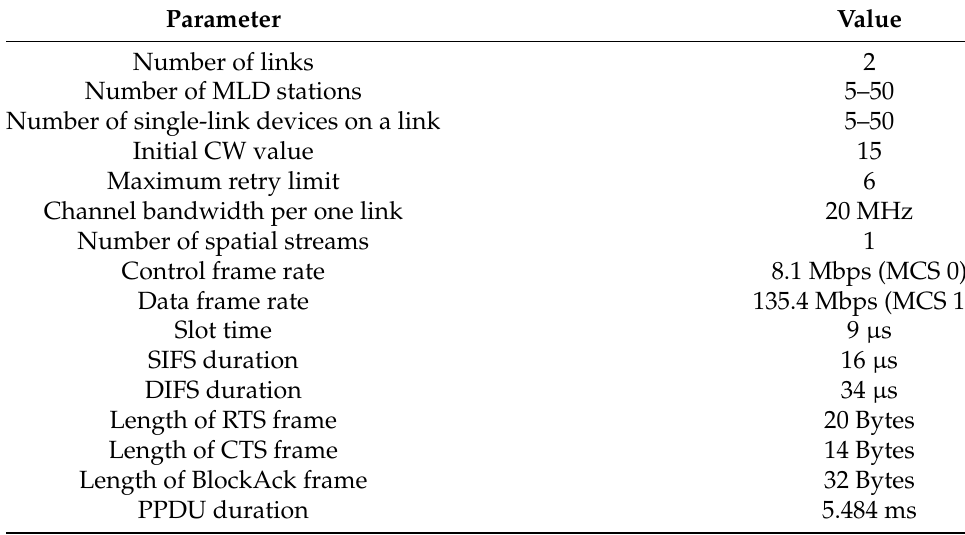
Table 1. Simulation